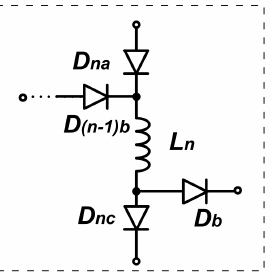
Figure 4. Switching inductor cell for fractional conversion